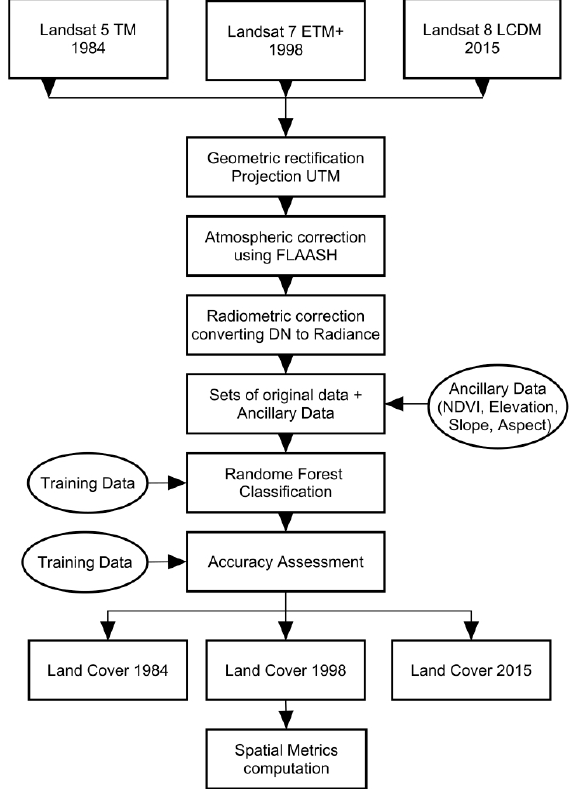
Figure 2. Flowchart of the general methodology.